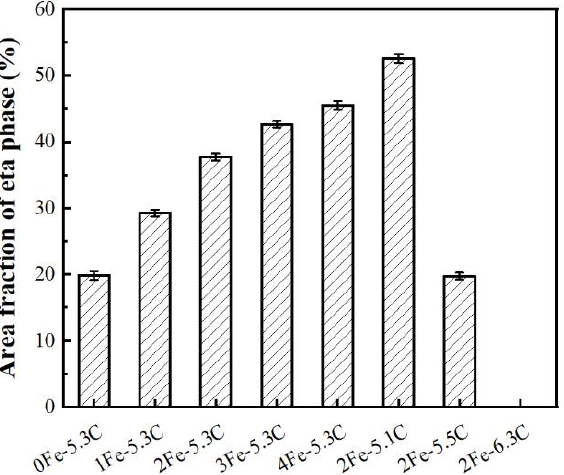
Figure 5. Area fraction of the eta phase of different WC–13 (Co–Fe) composites.